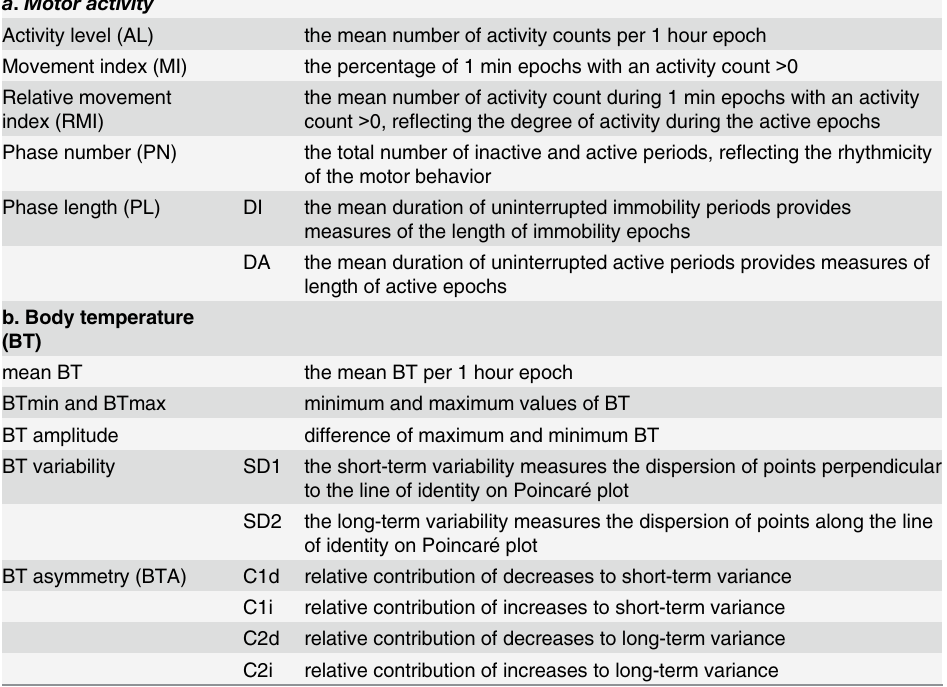
Table 2. Parameters used to describe motor activity (a) and body temperature